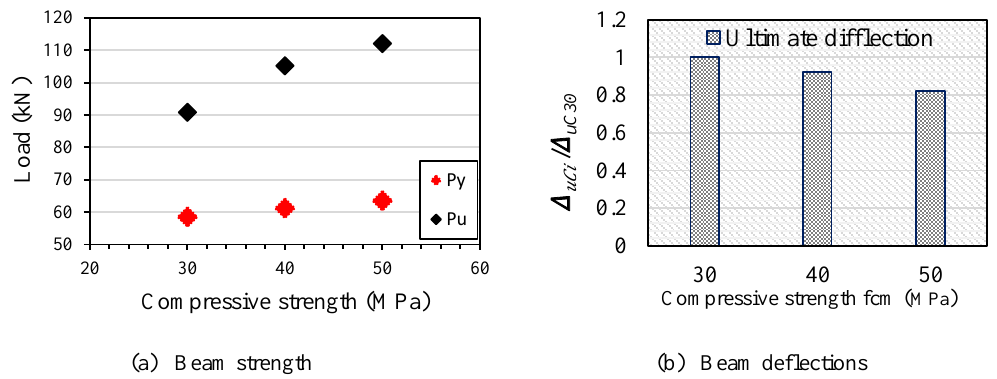
Figure 20. The concrete compressive strength effect on the ultimate strength and the ultimate deflection of the composite curved beam